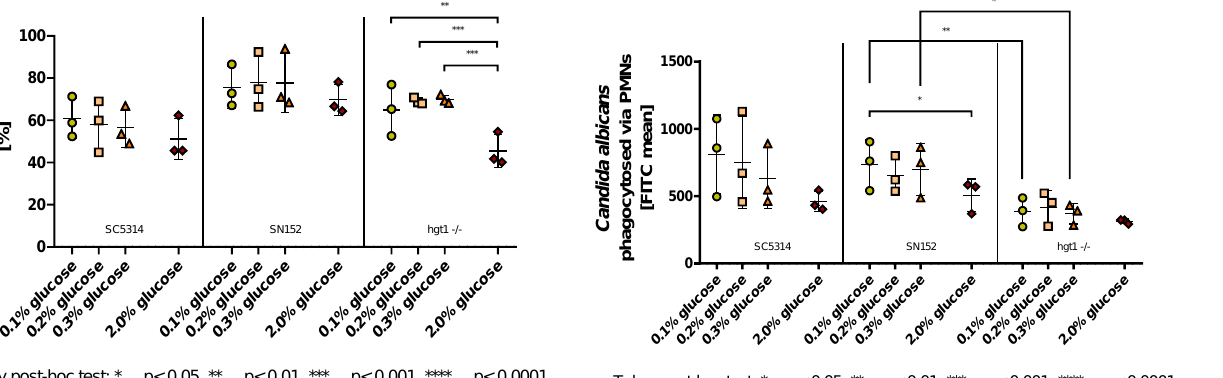
0.1% glucose ( − 350.7, 95% CI ( − 638.5, − 62.84), p = 0.0084) and 0.3% glucose ( − 331.4, 95% CI ( − 619.3, − 43.61), p =